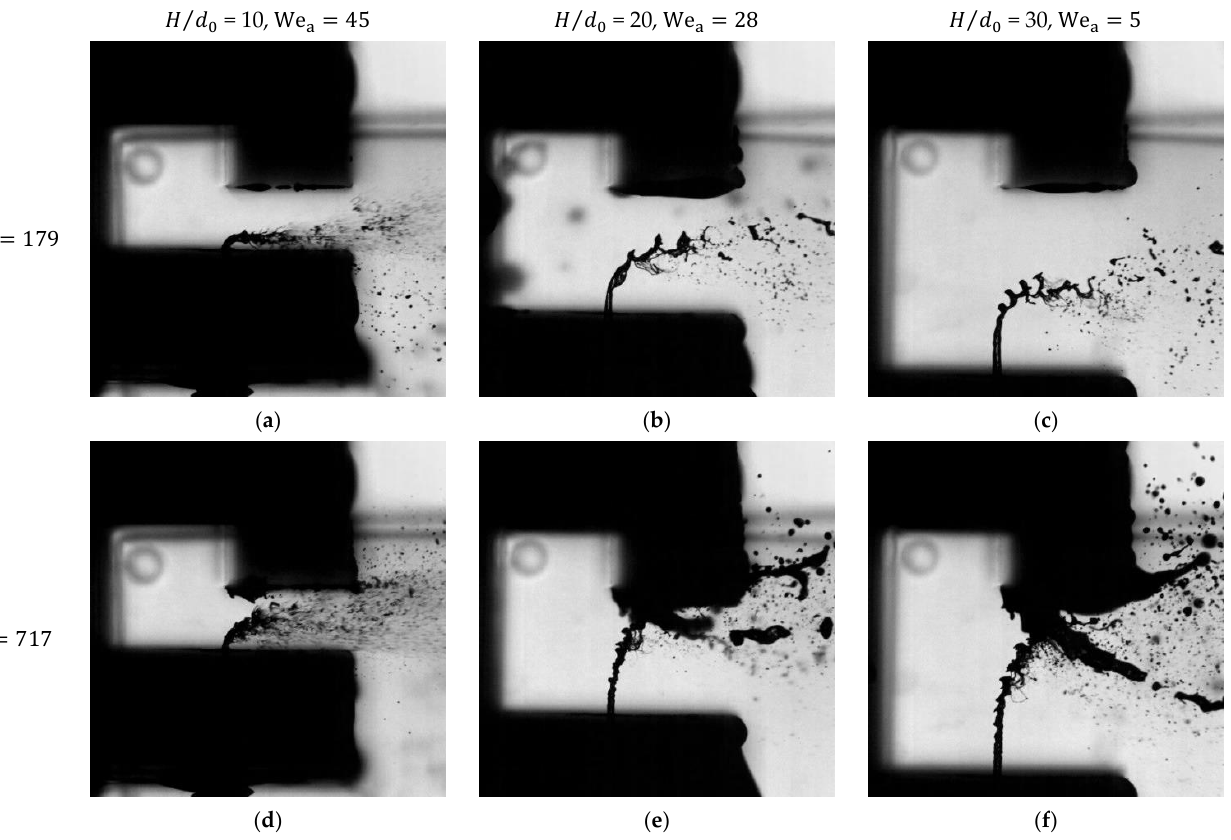
Figure 13. Instantaneous jet images for different parameter values; the mass flow rate of air is 46 g/s, ( a , d ) for 𝐻 𝑑 0 ⁄ = 10, We a = 45 ; ( b , e ) for 𝐻 𝑑 0 ⁄ = 20, We a = 28 ; and ( c , f ) for 𝐻 𝑑 0 ⁄ = 30, We a = 5 .